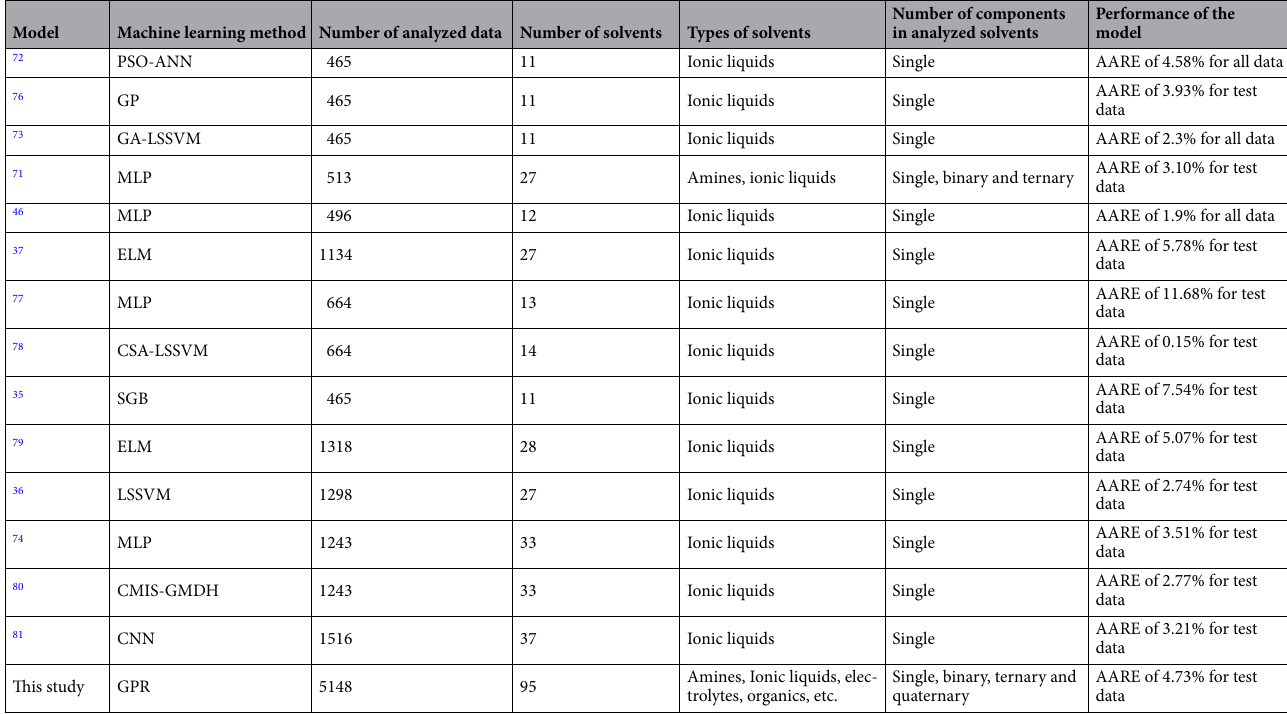
Table 4. Comparison between the analyzed conditions as well as the performances of the previous models and the one developed by GPR